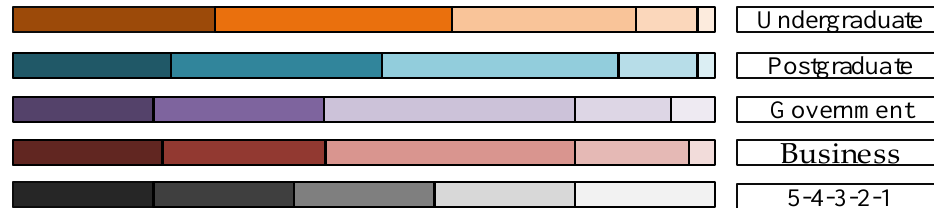
Figure 4. Individual attribute difference in BS travel willingness. Table 2. Demographic characteristics in this survey.